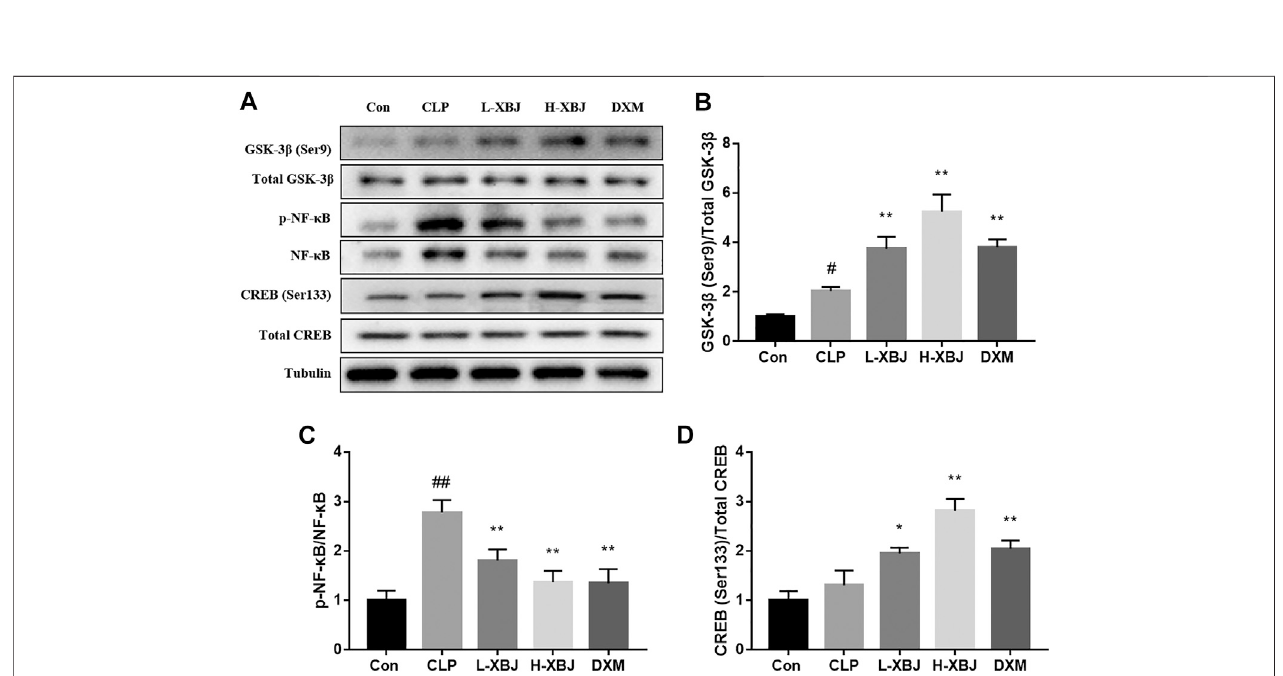
FIGURE 4| XBJ regulates the activities ofGSK-3 β , NF- κ B and CREB in theliver ofCLP-induced ALI mice (A) Representative immunoblots ofGSK-3 β , NF- κ B and CREBproteinexpression inliverlysates. (B-D) Administration ofXBJincreasedGSK-3 β andCREBactivity, whileNF- κ Bactivity wasreduced invivo. Con:controlgroup thatunderwentshamsurgery;CLP:modelgroupwithCLPsurgery;L-XBJ:groupwithCLPsurgery+XBJlowdosegroup(4 ml/kg/day);H-XBJ:groupwithCLPsurgery + XBJ high dose group (8 ml/kg/day); DXM: group with CLP surgery + Dexamethasone (5 mg/kg/day). Compared with the control group, # p < 0.05, ## p < 0.01 were considered to be signi fi cant; Compared with the CLP group, * p < 0.05, ** p < 0.01 were considered to be signi fi cant. Data are expressed as mean ± SD.